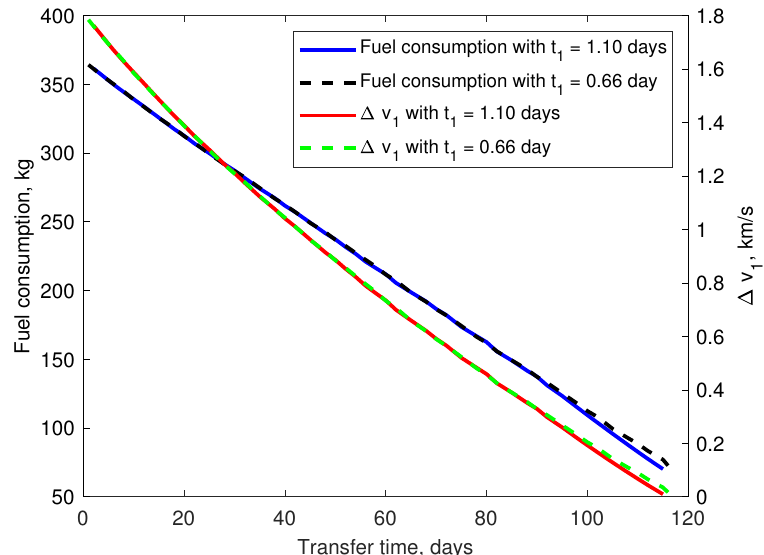
Figure 1. The variation in fuel consumption with transfer time and variation in magnitude of impulsive burn with transfer